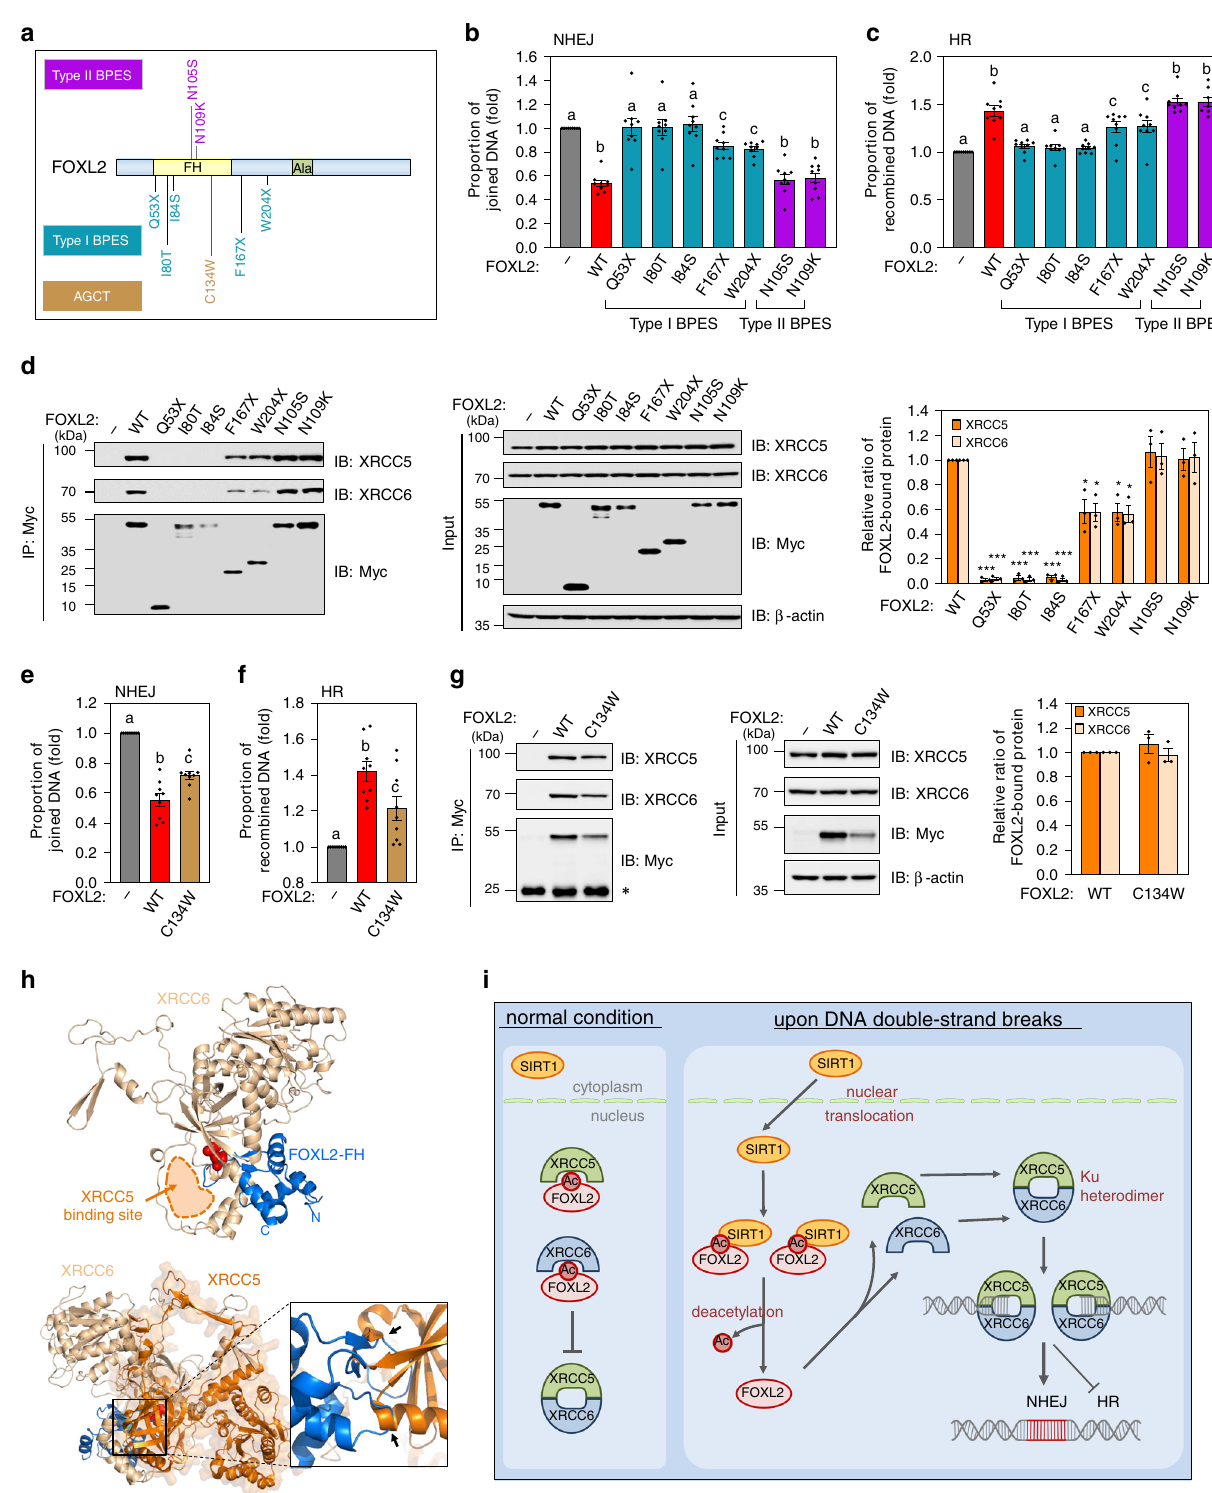
penicillin-streptomycin. Cells were transfected with Lipofectamine 2000 or 3000 (Invitrogen) according to the manufacturer ’ s instructions. RNA interference . The siRNA sequences against FOXL2 (5 ′ -GCUCCUGUCGCU CCUCUUU-3 ′ ), SIRT1 (5 ′ -ACUUUGCUGUAACCCUGUA-3 ′ ), and scrambled siRNAs (SN-1001-CFG) were purchased from Bioneer (Daejeon, Korea). Cells were transfected with siRNAs using Lipofectamine 2000 or 3000 (Invitrogen) according to the manufacturer ’ s instructions 17 .